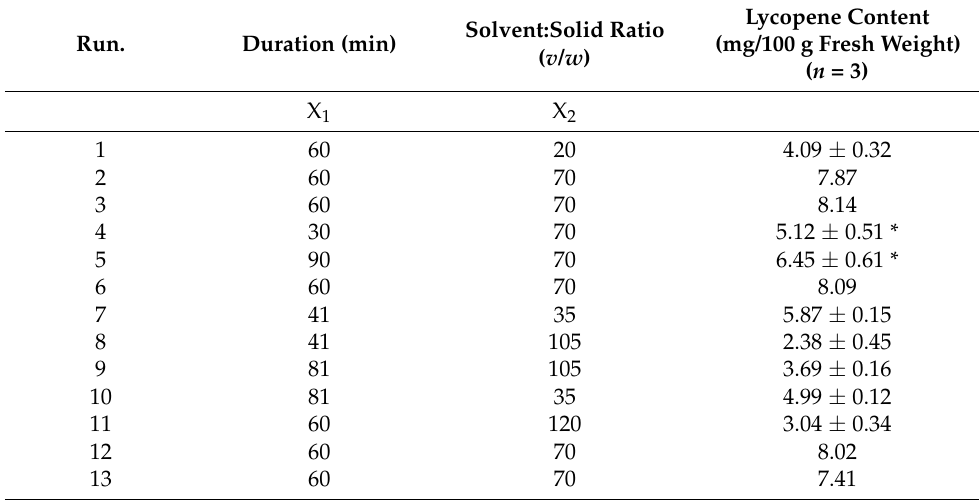
Table 3. Experimental design and responses of the dependent variable expressed as mg lycopene/100 g fresh weight.